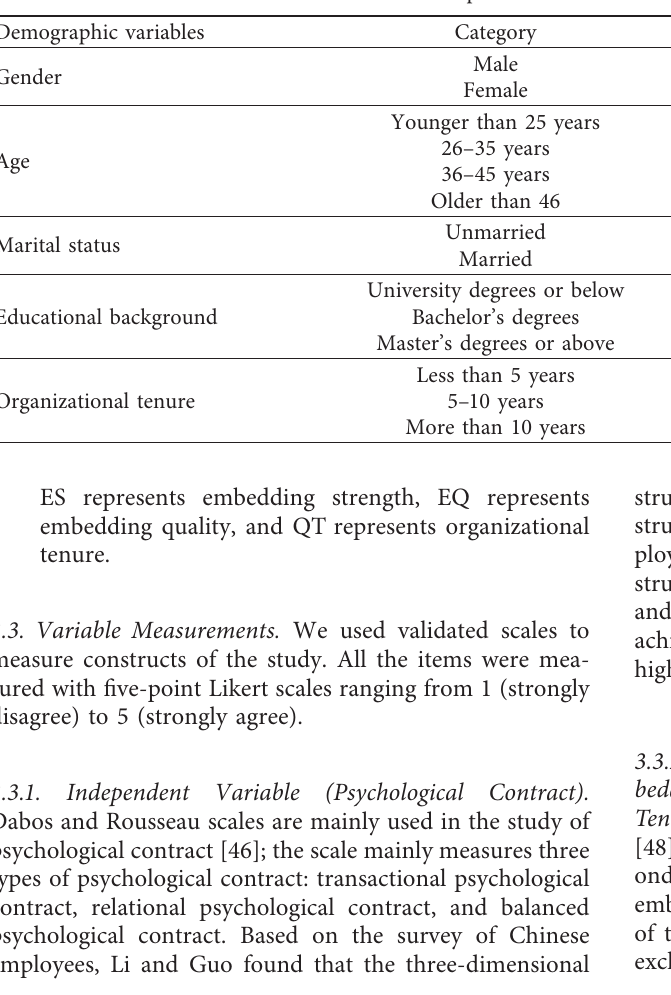
Figure 1: Research model of the influence mechanism of psychological contract on employee innovation behaviour. Table 1: Description of the basic characteristics of the